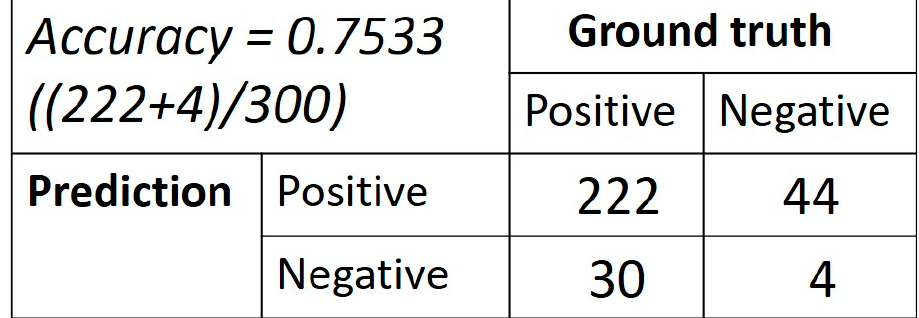
6 Table 1. Demographic data of the enrolled subjects with a positive or negative collateral status. Collateral Status